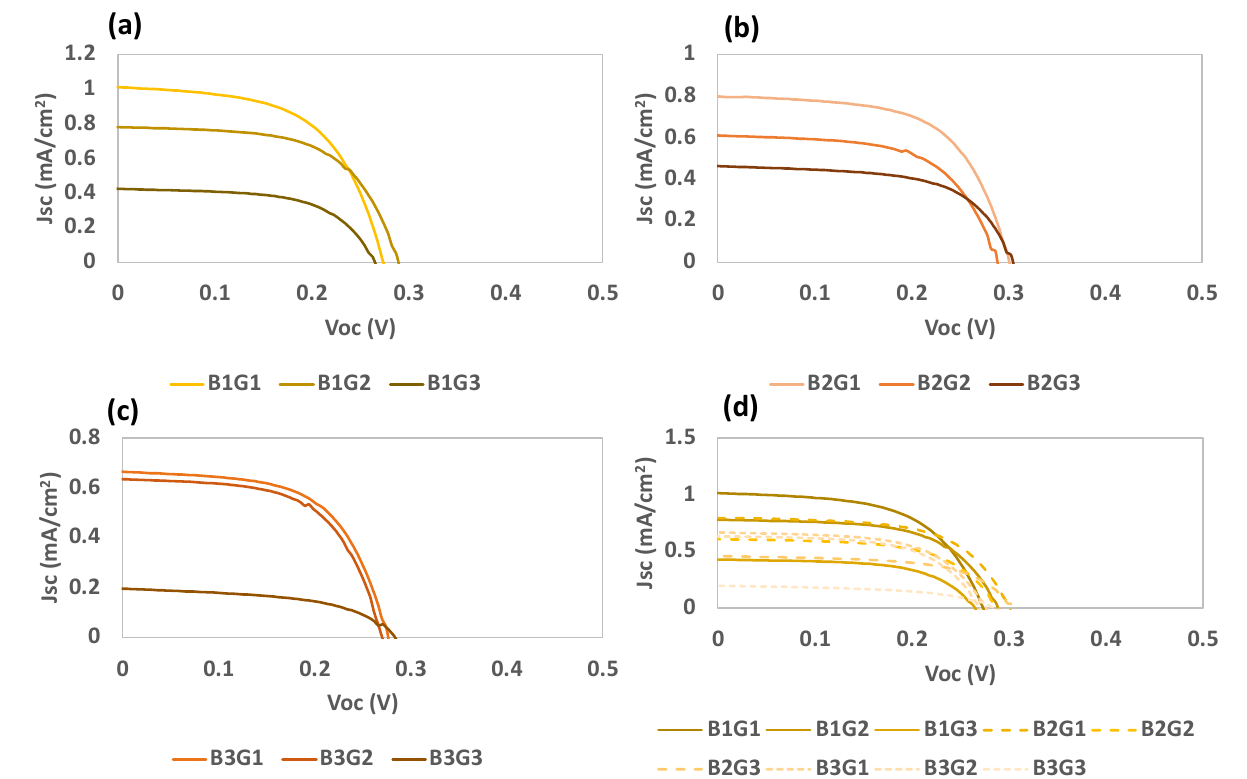
Table 6. Photovoltaic performance parameters of DSSCs based on the use of COF RIO-60 as an in- terface between TiO 2 and the reference dye N719 for the best-performance batch under simulated AM 1.5G illumination at 100 mW/cm 2 . ( The presented results correspond to the best-performing cell ). Parameters